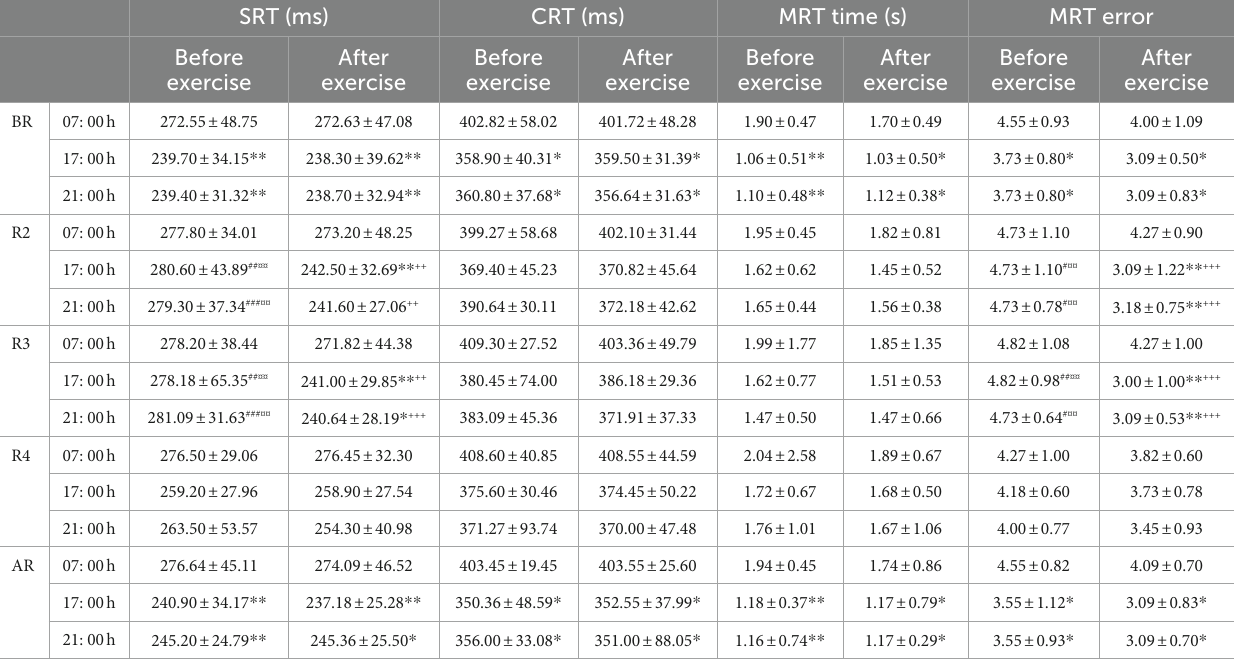
TABLE 6 Values (mean ± SD) of simple reaction time (SRT) and choice reaction time (CRT) measured during the three times of the day (07:00, 17:00, and 21:00 h) 1 week before Ramadan (BR), the 2nd week of Ramadan (R2), the 3rd week of Ramadan (R3), the 4th week of Ramadan (R4), and 2 weeks after Ramadan (AR; n = 11).